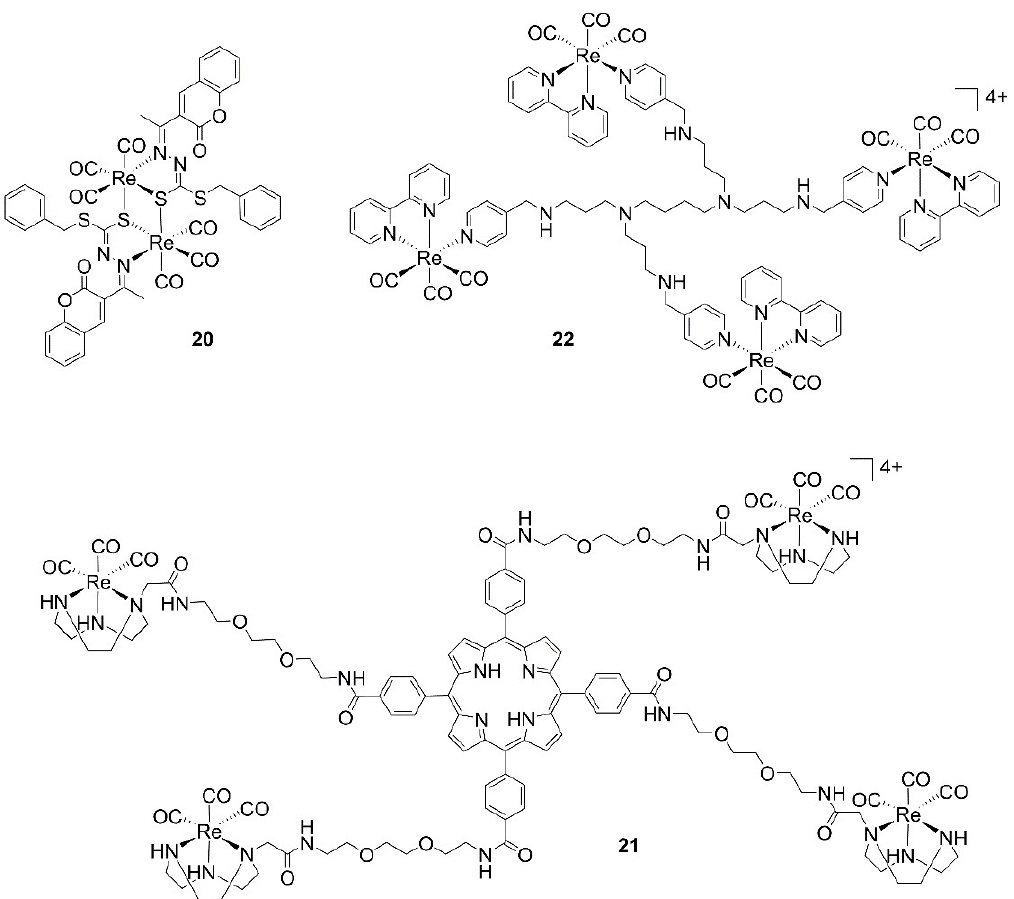
Figure 3. Selected structures of homonuclear anticancer complexes.